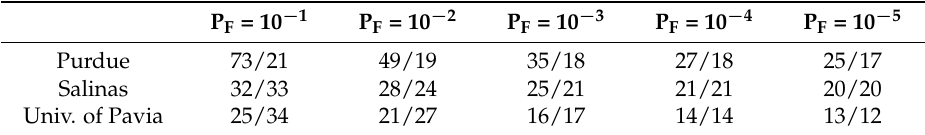
Table 1. n BS estimated by HySime and HFC/NWHFC.